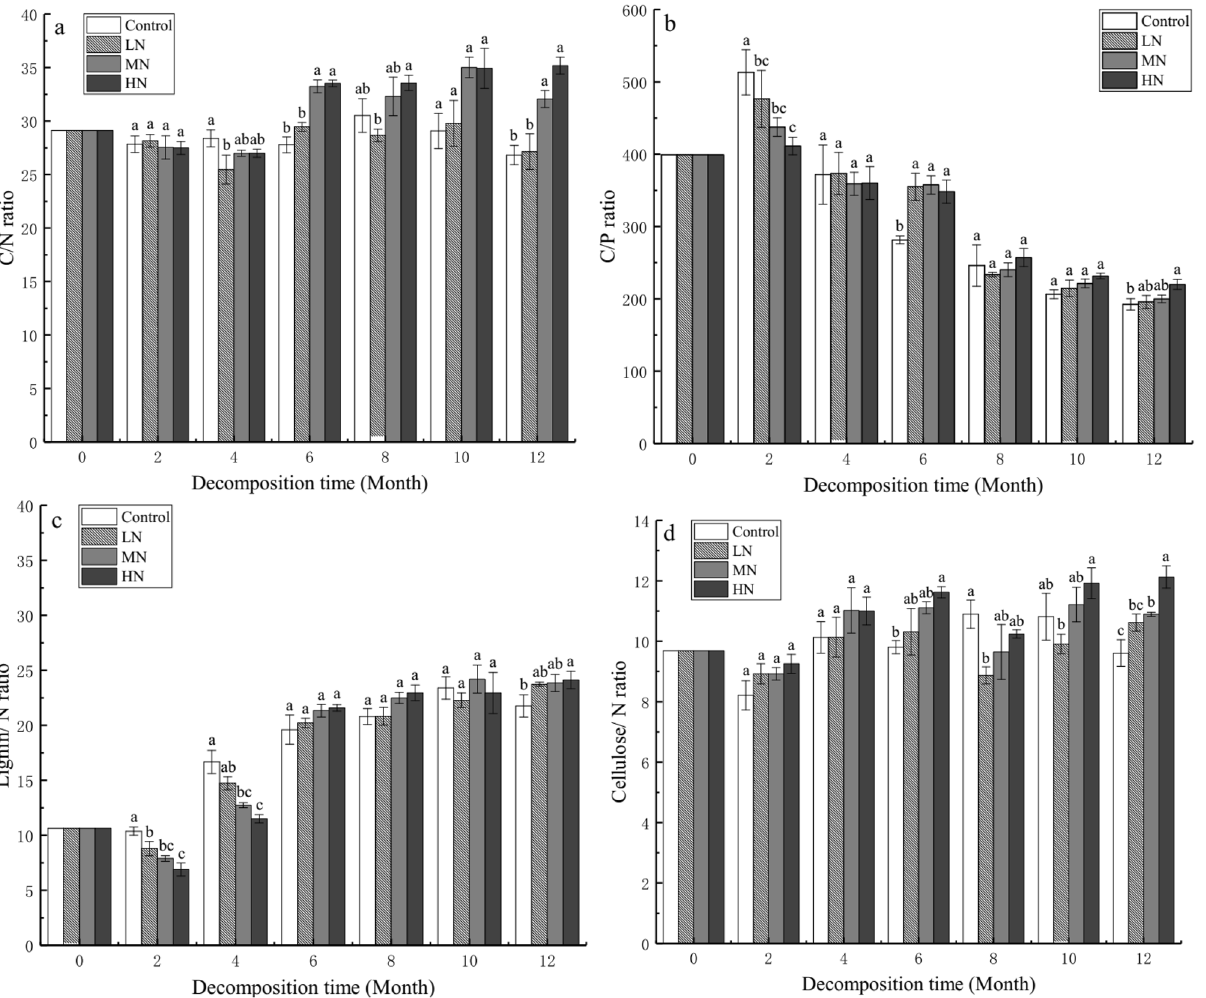
Figure 4. Changes in carbon (C)/nitrogen (N), C/phosphorus, lignin/N, and cellulose/N ratios with different nitrogen treatments during leaf litter decomposition. Values are expressed as mean ± standard error (SE) (n = 3). Values marked with different letters were significant ( P <